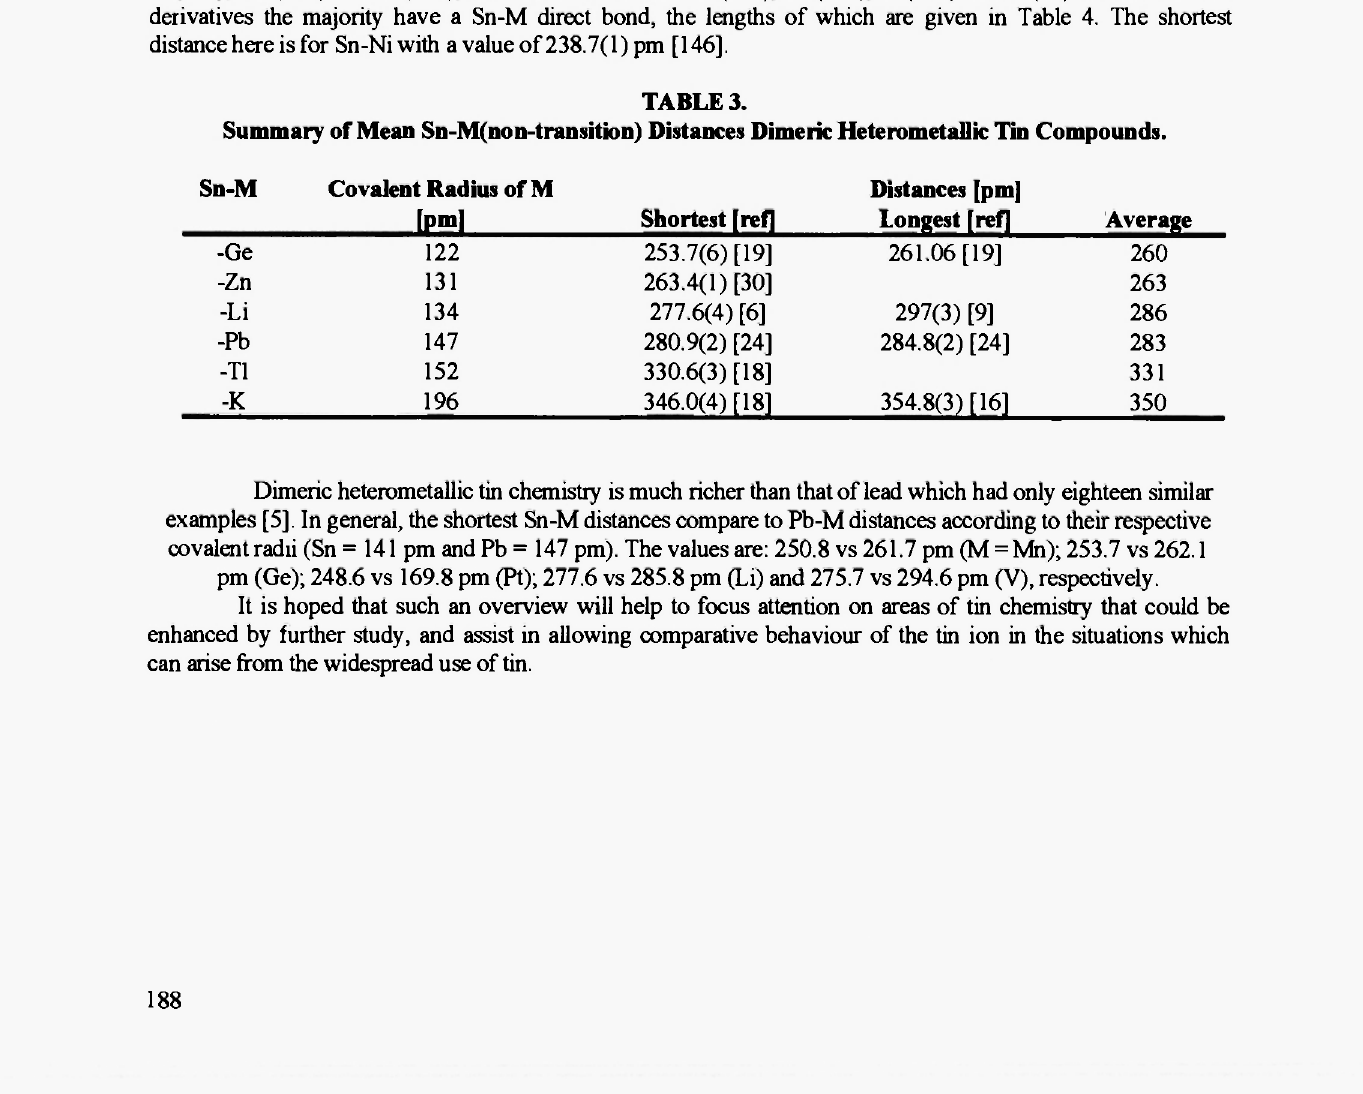
Summary of Mean Sn-M(non-transition) Distances Dimeric Heterometallic Tin